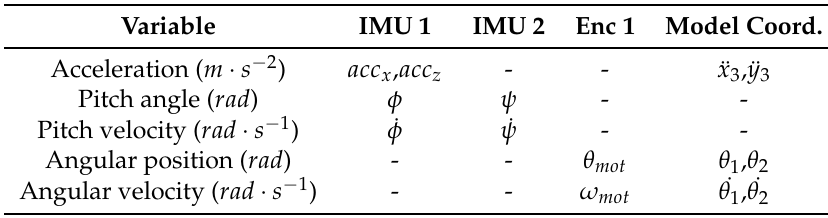
Table 1. Notation summary for variables from the theoretical model (last column) and each sensor, i.e. , IMUs and optical